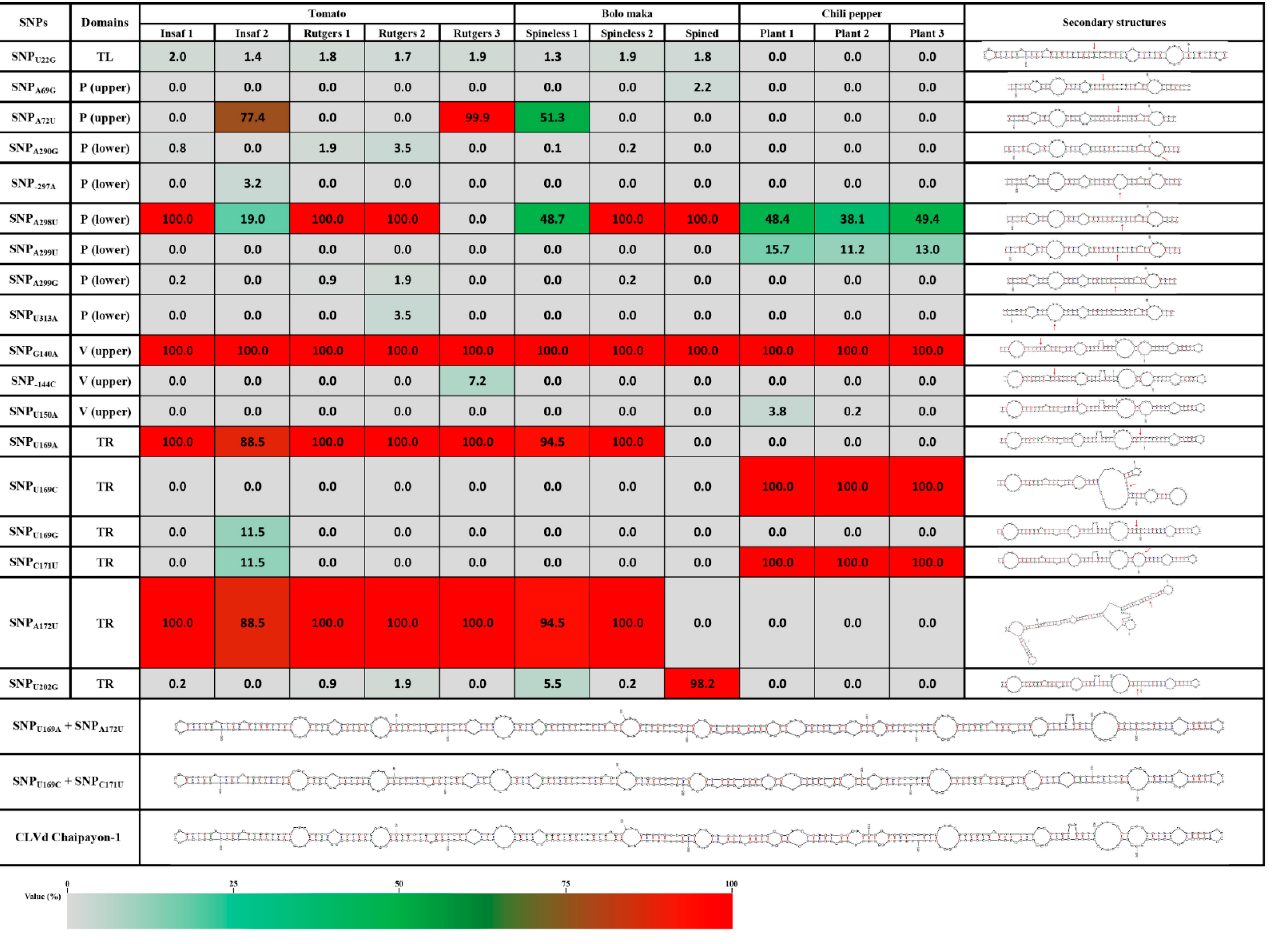
Figure 3. Structural consequences of major single-nucleotide polymorphisms (SNPs) of dominant variants and mutation frequency (in percentage) per individual plant. The table shows the positions and domains where mutations occurred with mutation frequency in percentage and the secondary structures. The color scale represents a mutation frequency ranging from grey (0%) over green and brown to red (100%).